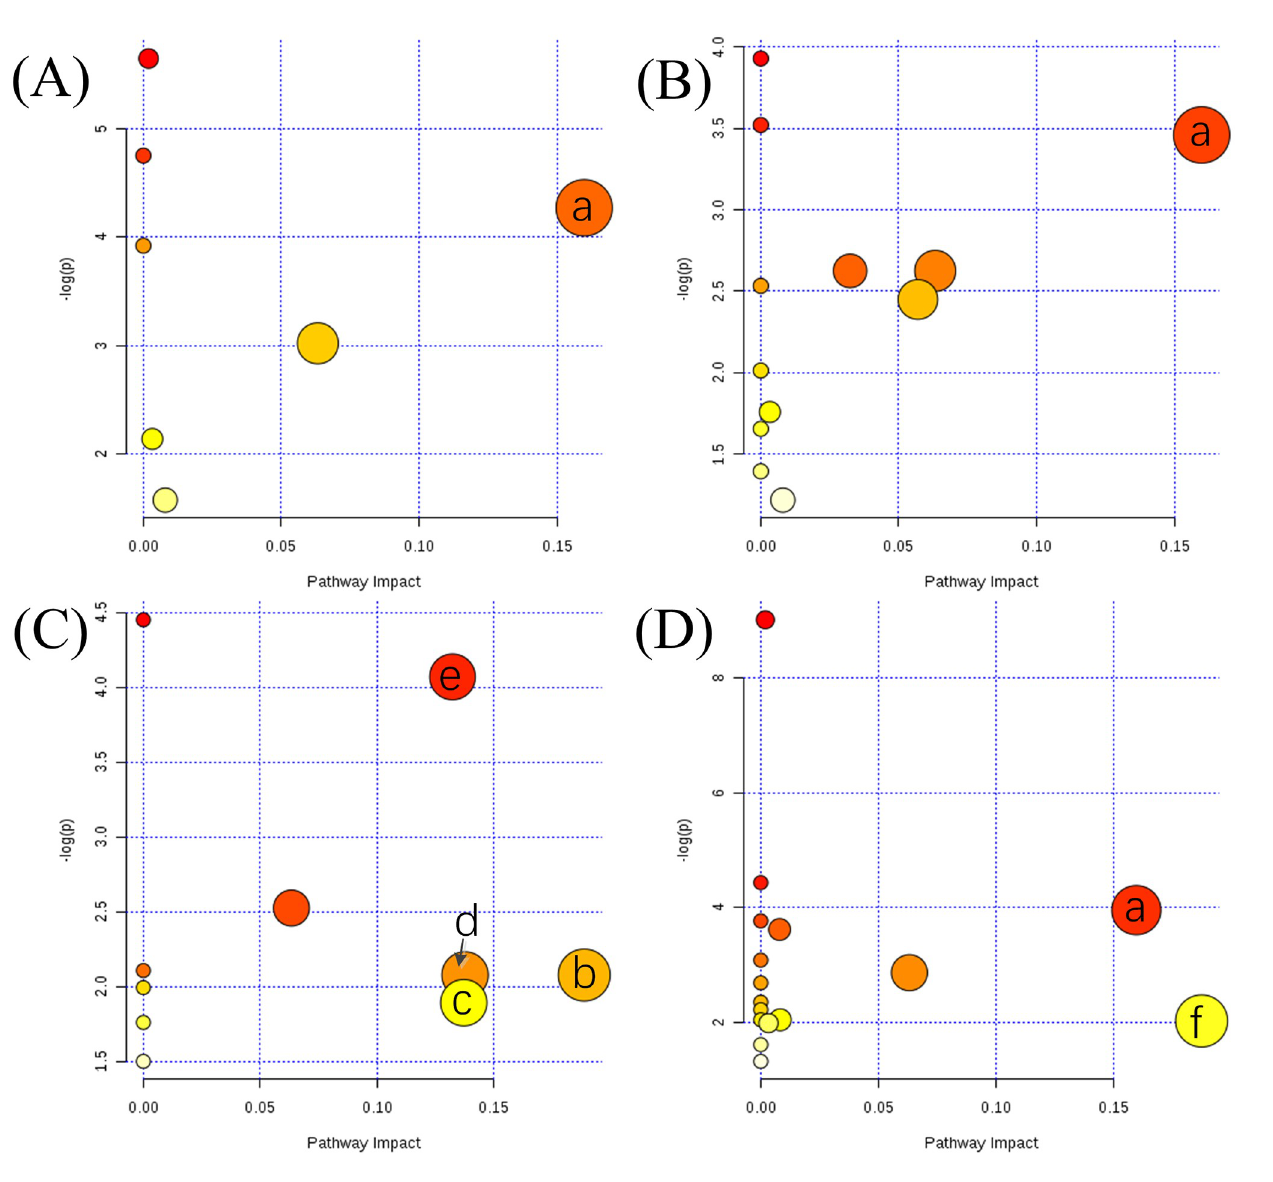
Fig 4. Summary of altered metabolic pathways analysis with MetPA when comparing (A) TE to HC, (B) AS to HC, (C) OL to HC, and (D) AZ to HC. a: arginine and proline metabolism; b: glycerolipid metabolism; c: inositol phosphate metabolism; d: pyruvate metabolism; e: glyoxylate and dicarboxylate metabolism; f: glycine, serine and threonine